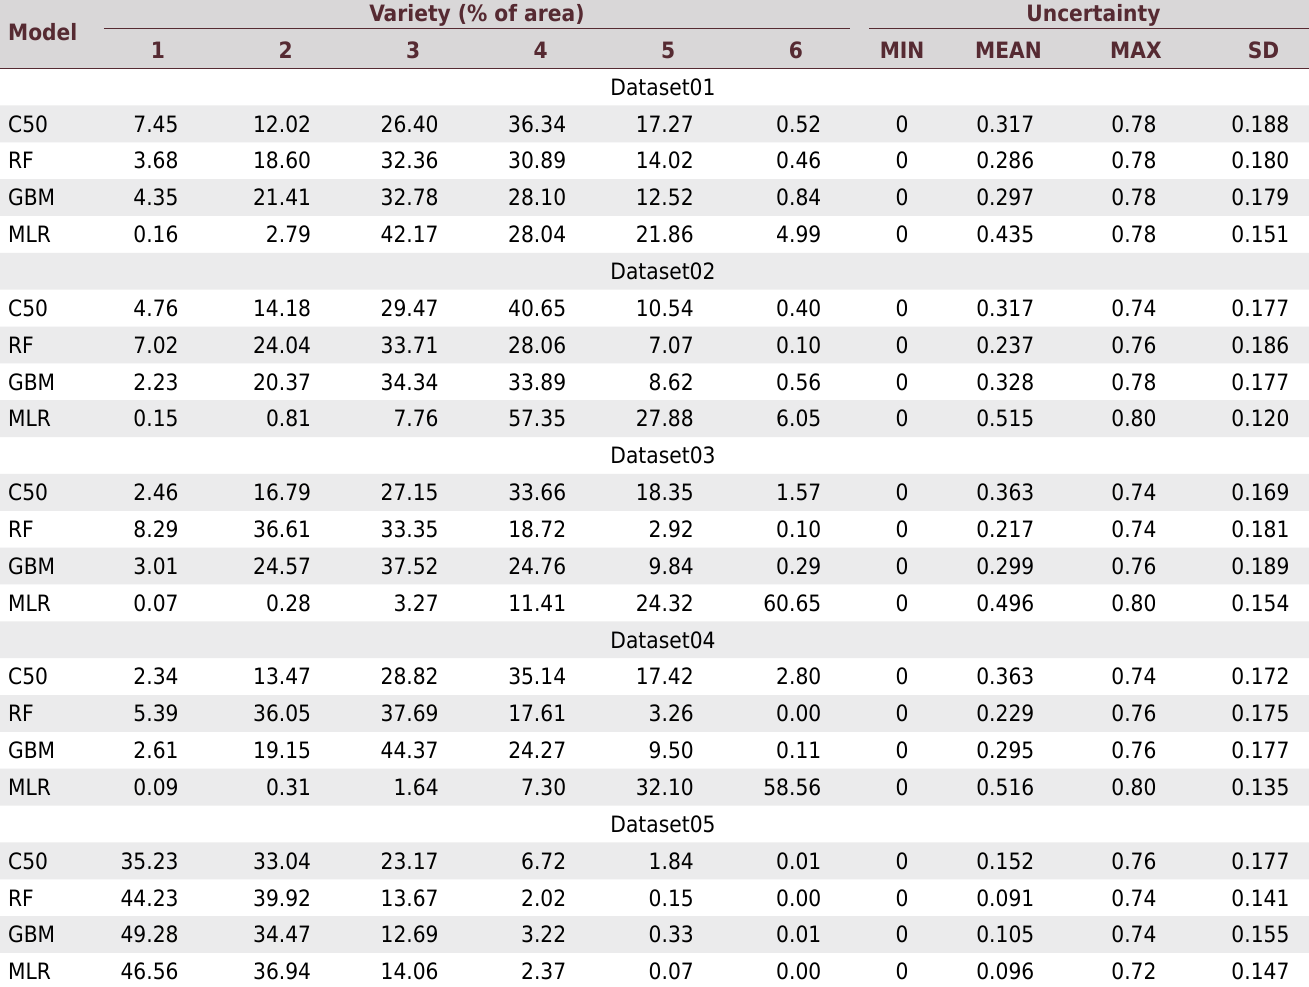
Table 3. Variety in % of area and Uncertainty basic statistics to the models and datasets